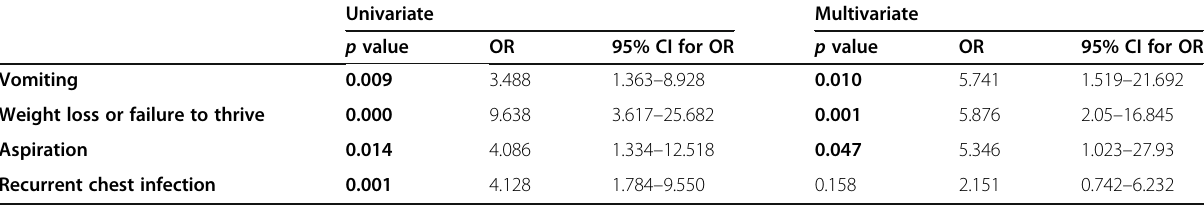
Table 2 Multinomial logistic regression model assessing independent predictors of upper GI series